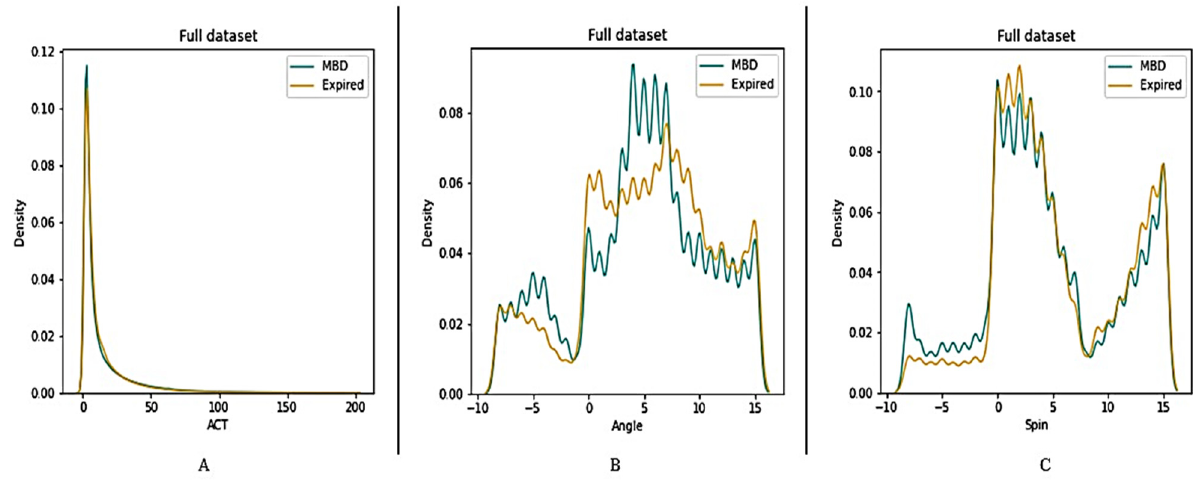
Figure 8. Description of wearable dataset at full dataset interval based on ( A ) ACT, ( B ) Angle ( C ) Spin. Table 2. Statistical difference in ACT, angle, and spin values for MBD and expired in 12 h data. Group